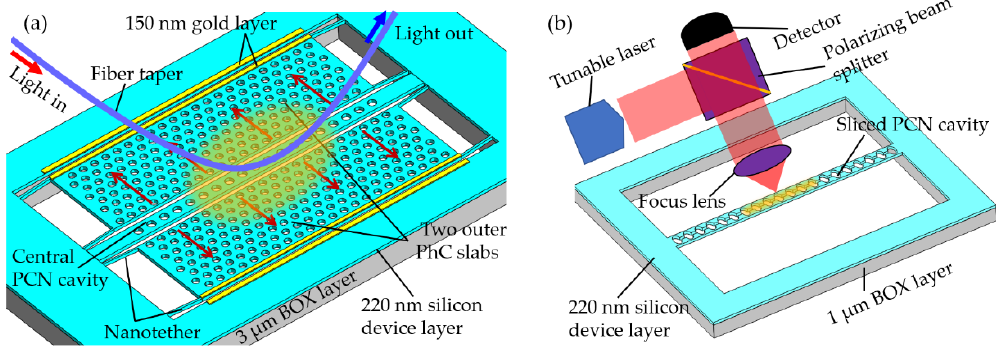
Figure 17. Schematics of optomechanical crystals for displacement sensing: ( a ) a central PCN cavity coupled to double-slotted photonic crystal slabs [120] ; ( b ) sliced PCN cavity [47] .